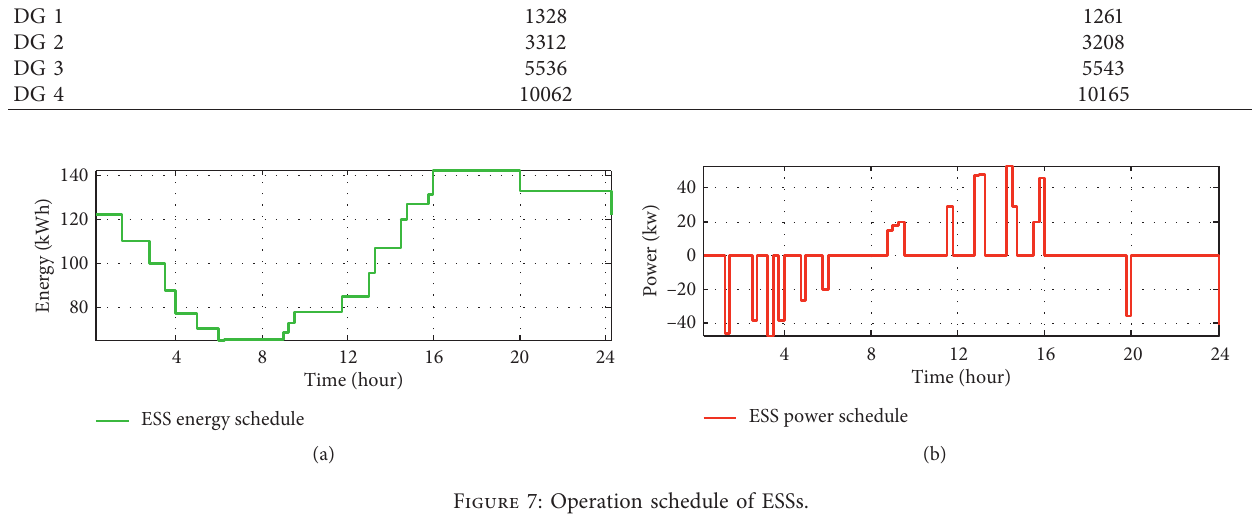
Figure 7: Operation schedule of